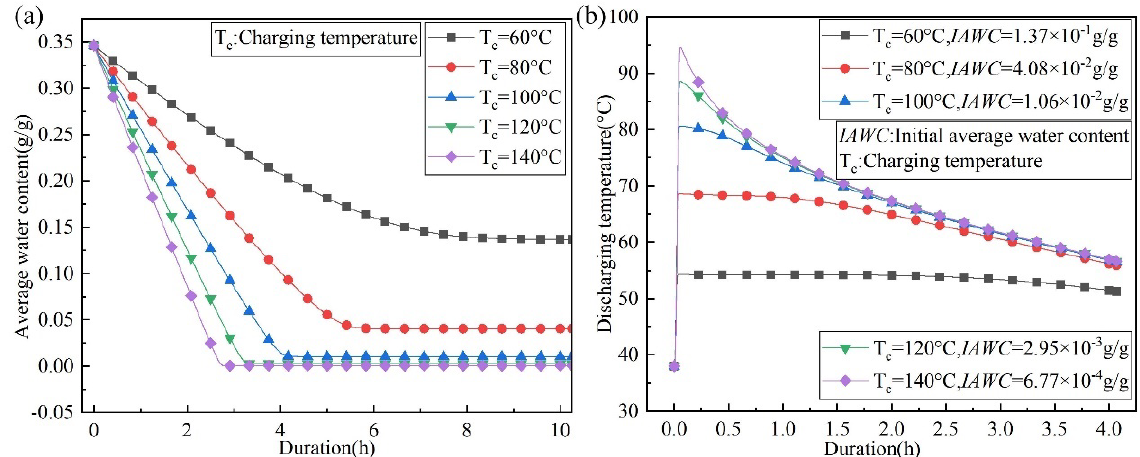
Figure 11. ( a ) Change in the average water content in the reactor during the charging process; ( b ) change in the air outlet temperature during the discharging process (mass fraction of water vapor during the charging process is 3.53%) varies with time.